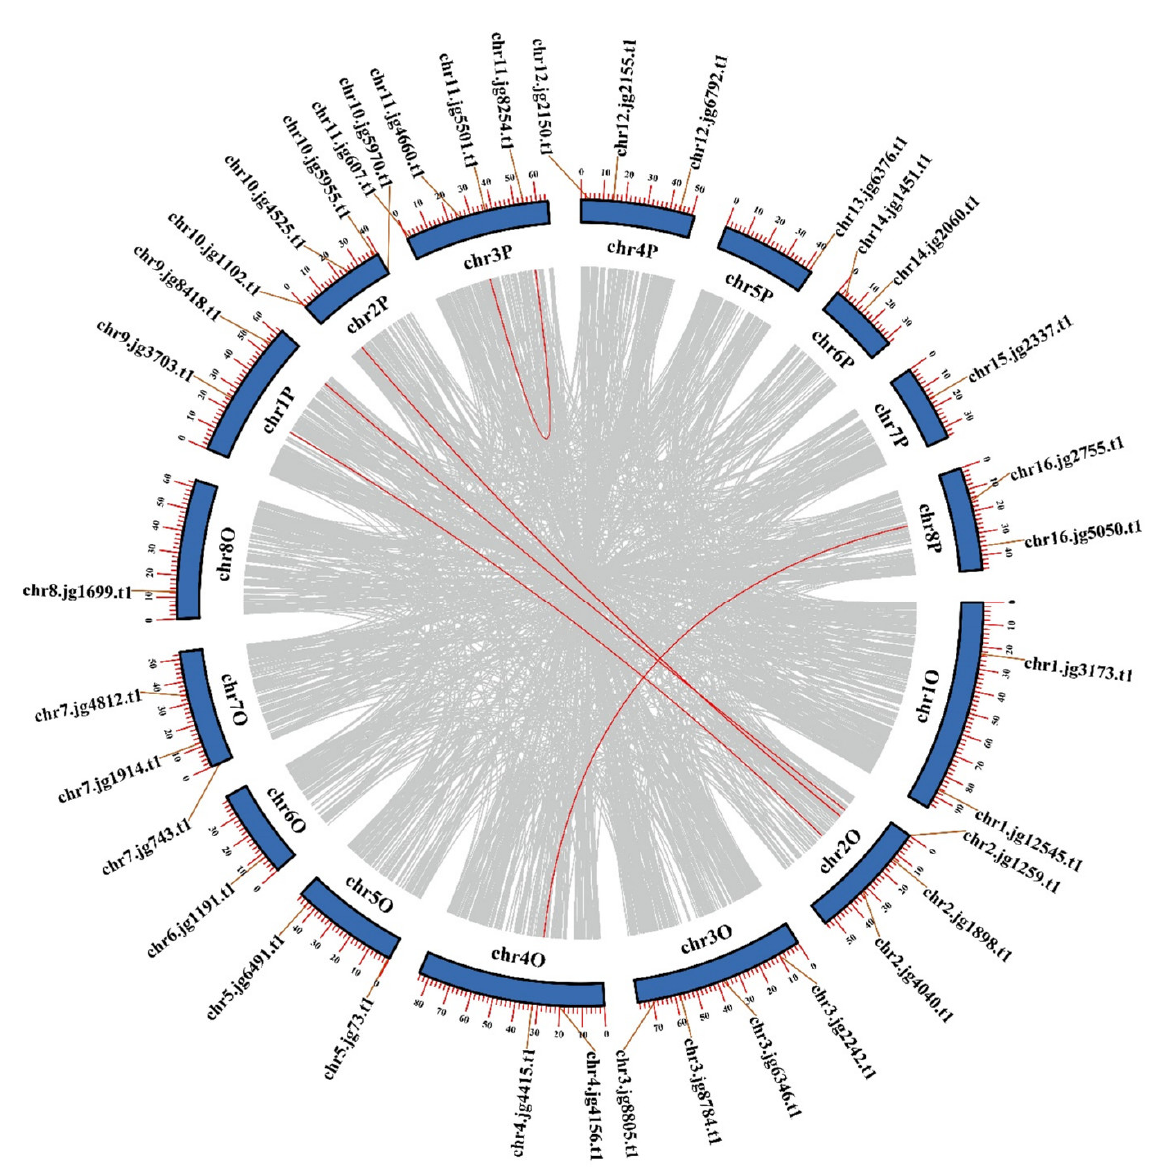
Figure 6. Segmental repeat analysis of SPL genes in T. repens genome. The 16 chromosomes form a circle, and the red lines represent the syntenic region of the 37 TrSPL genes. All synteny block pro-